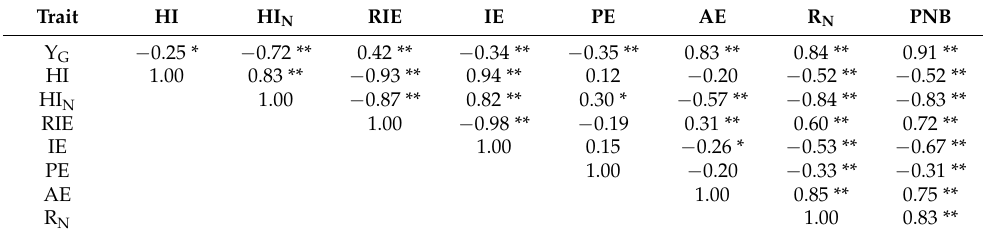
Table 5. Matrix of correlation indices for yield and efficiency indices, n = 84. Trait HI